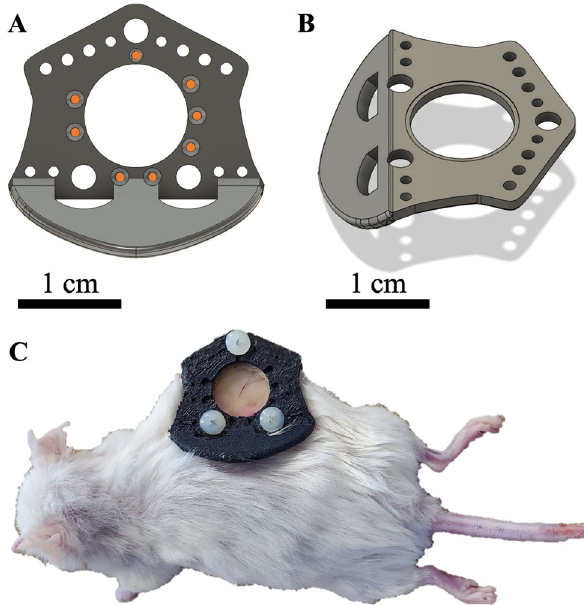
Figure 1. MR-compatible plastic window chamber mouse model. 3D rendering of top ( A ) and bottom ( B ) surface of MR compatible plastic window chamber designed in Autodesk Fusion 360 CAD software version 2.0.12160 (Autodesk Inc., San Rafael, CA, USA). Divots for fiducial marker placement are marked by the orange circles in ( A) . ( C) Plastic window chamber on a tumor bearing